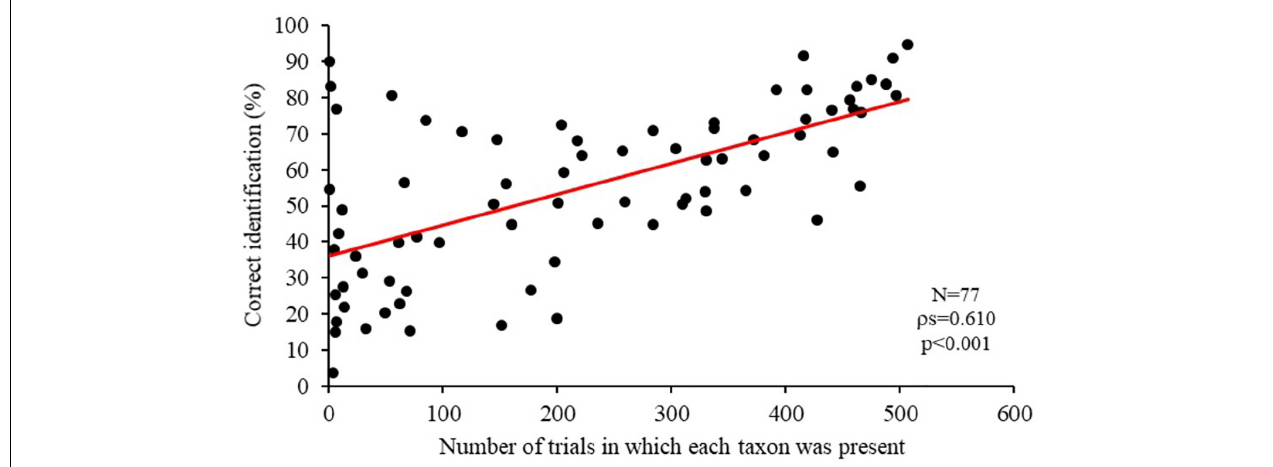
FIGURE 5 | Significant correlation between the percentage of correct identification performed by volunteers (expressed as mean percentage for each taxon) and number of trials in which each taxon was present (based on the control diver sighted). Based on 72 studied taxa, litter presence and sight of damaged corals (see Table 3 ). Indicated in red the trendline of the correlations. N = number analyzed organisms; ρ s = Spearman coefficient value.